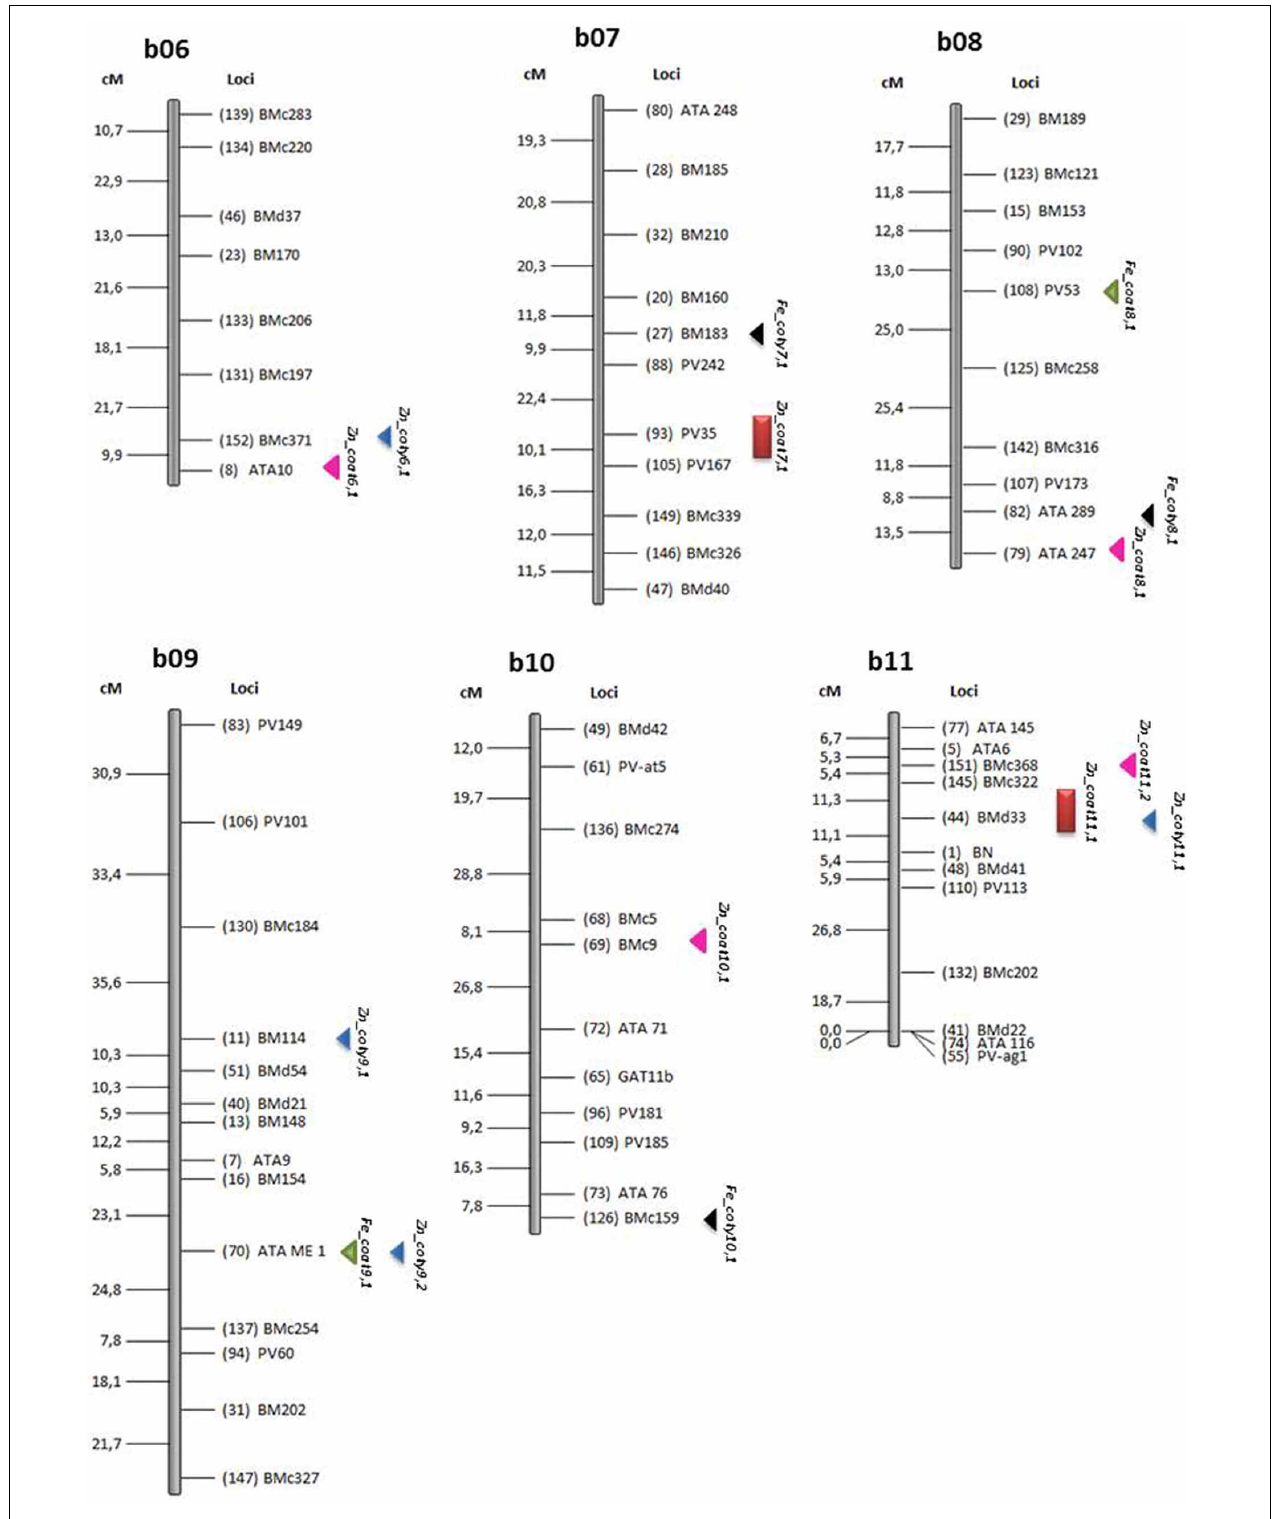
FIGURE 2 | Location of quantitative trait loci (QTL) for iron (Fe) and zinc (Zn) concentration in seed coat. Those QTL identified by CIM analysis in the (Cerinza × (Cerinza × (Cerinza × G10033))) advanced backcross population are indicated by thick bars acompanied by a QTL name as